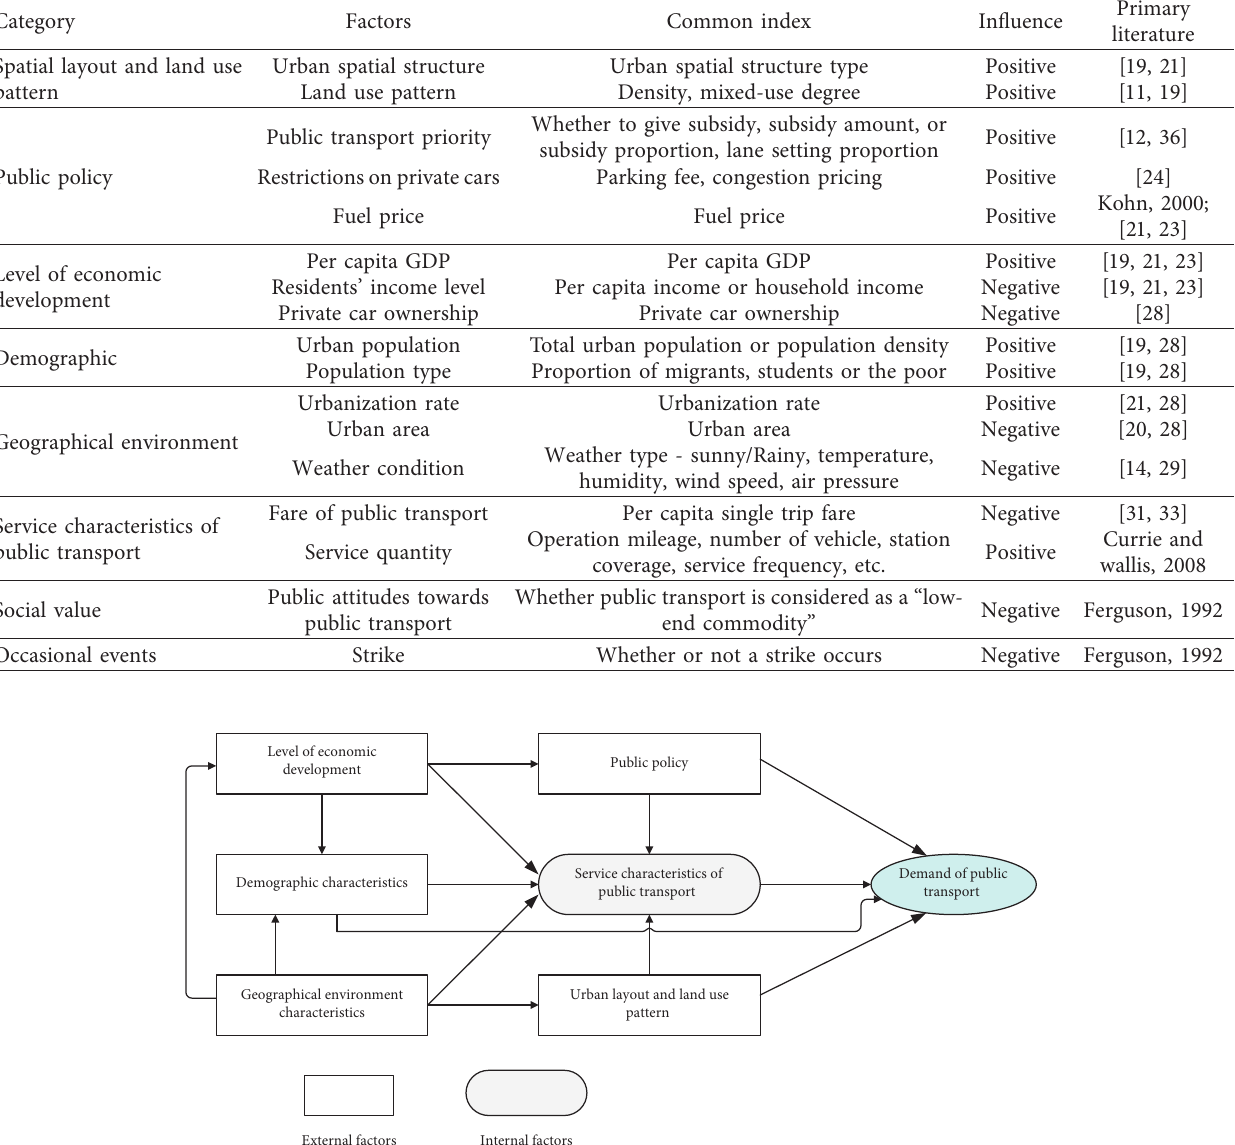
Figure 4: Factors affecting the demand for public transport and their